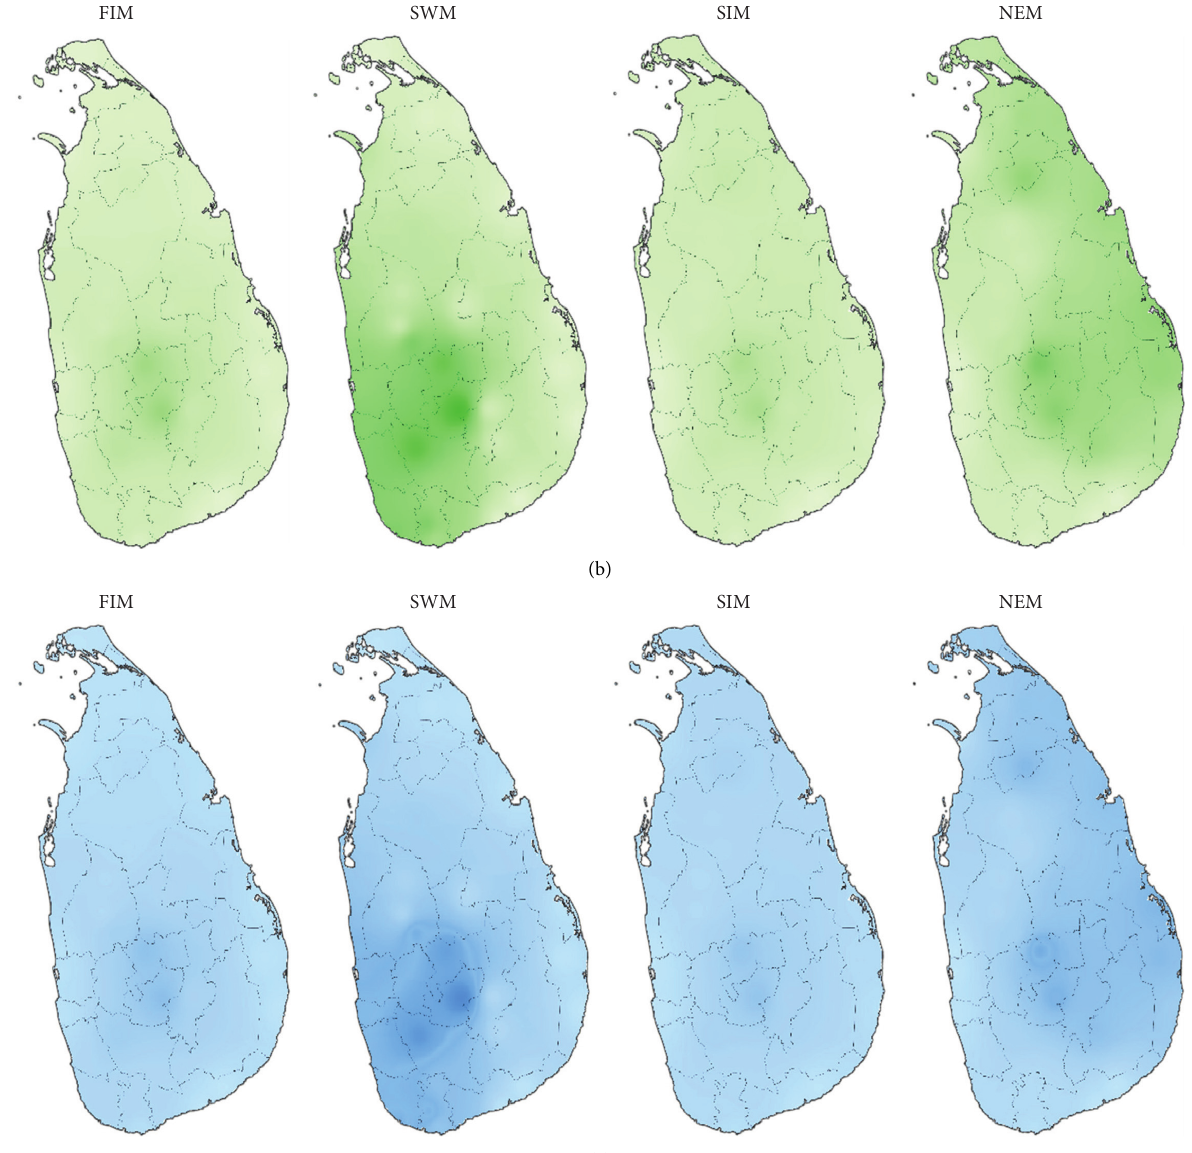
Figure 8: Far-future indices under RCP8.5 (2071–2100). (a) For normalized DI. (b) For normalized WI. (c) Moisture